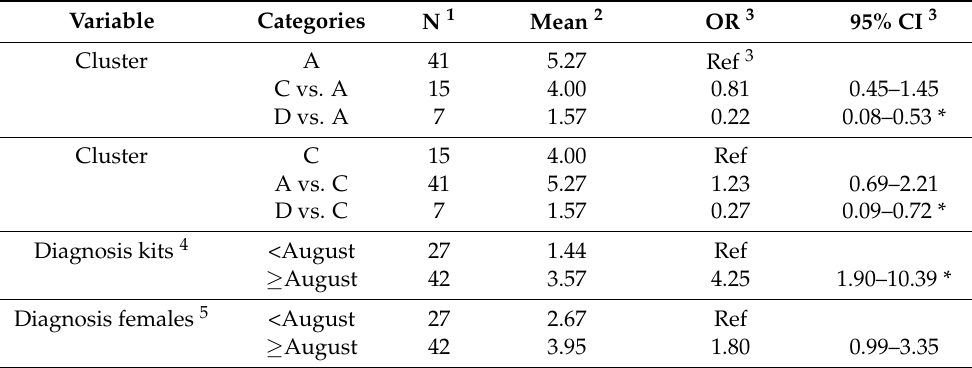
Table 2. Summary statistics and odds ratio (OR) and 95% confidence interval (95% CI) for the presence of clinical signs at farm level with virus cluster and time of diagnosis in kits or adult females for all 69 infected